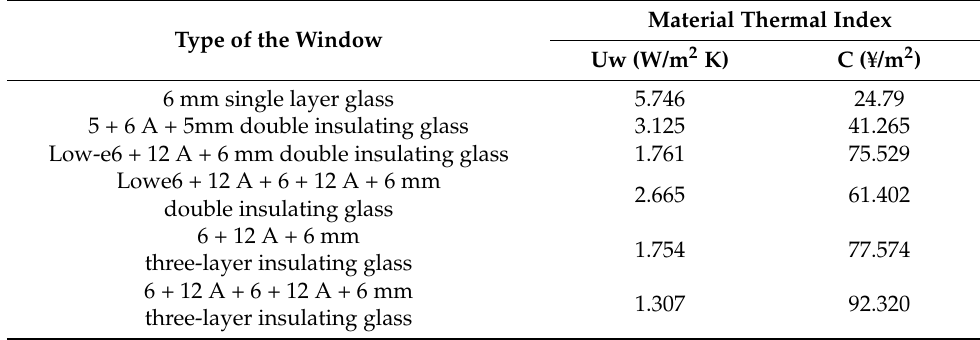
Table 11. Heat transfer coefficients and retrofit costs of external